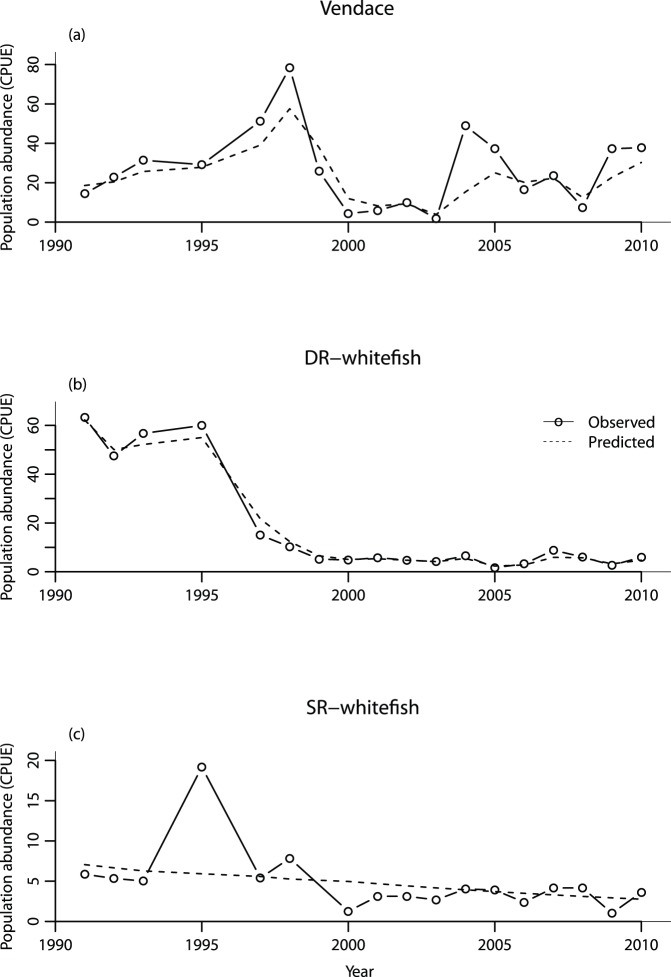
Population trends as observed (circles connected by solid lines) and as estimated with the EGSS modelling procedure for the full 1991–2010 period (dashed lines) for vendace (A), DR-whitefish (B), and SR-whitefish (C).